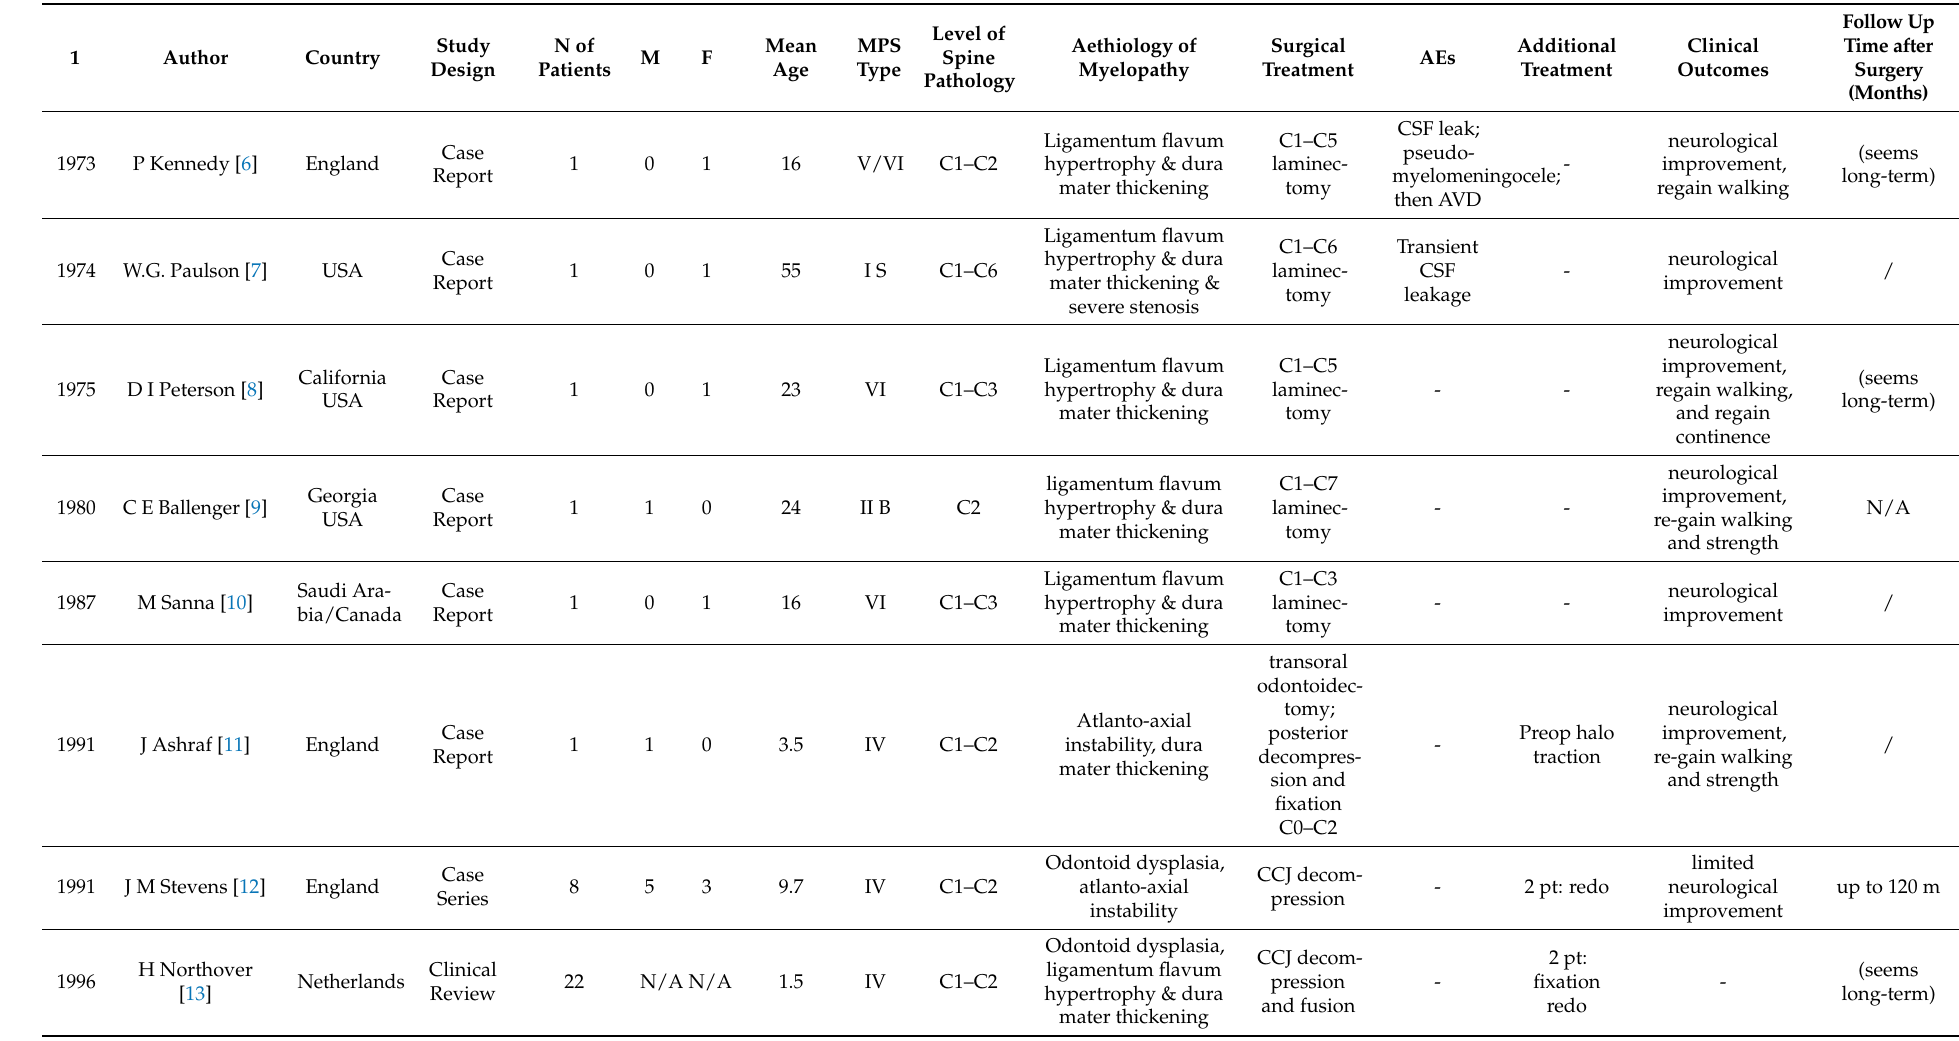
Table 1. Demographic and clinical data from our studies’